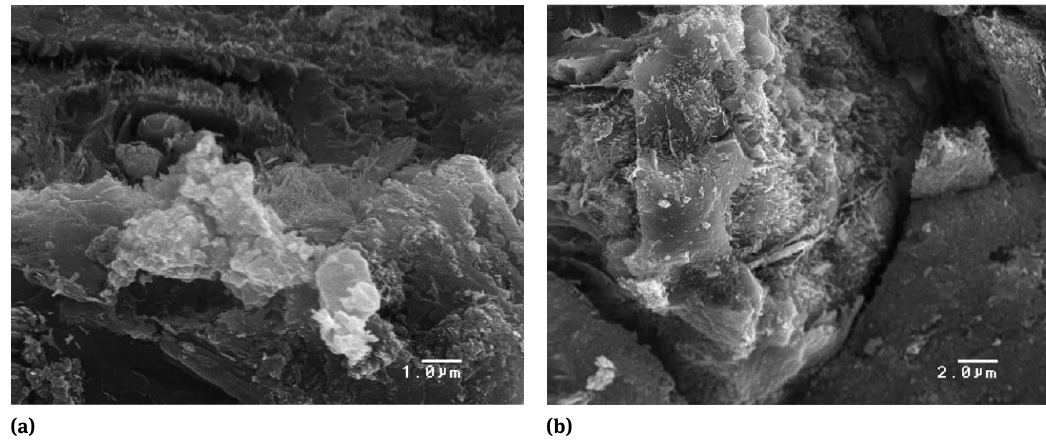
Figure 5: SEM micrographs of paste containing nano-SiO 2 particles 10,000 × and (b) 5000 × [102]